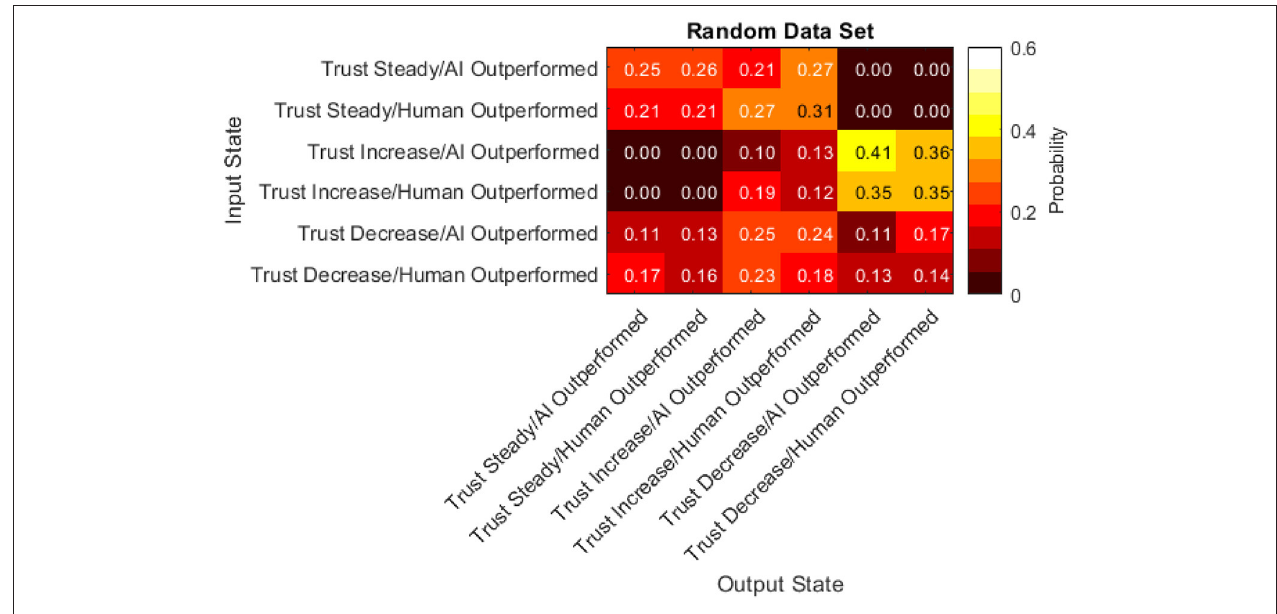
FIGURE 16 | Transition matrix from randomly generated data set.